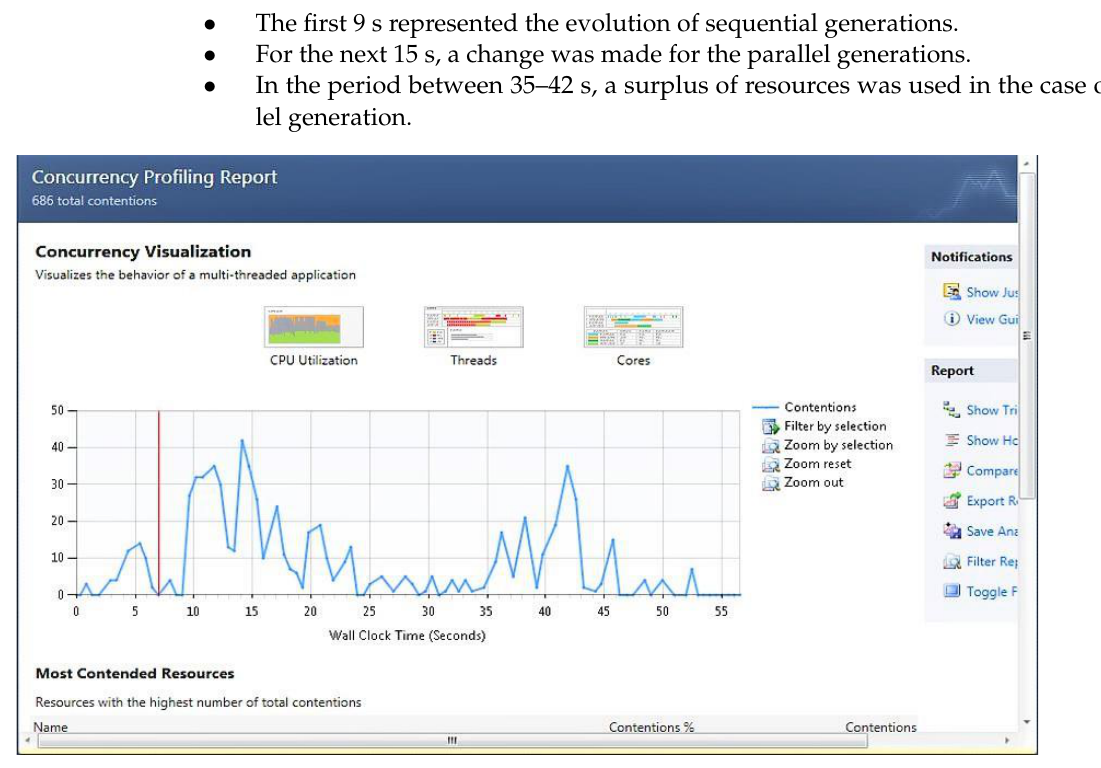
Figure 9. Visualization of resource conflicts (concurrency) at processor resources. The processor-level study refers to the distribution of competitive resources for threads and their use percentages.